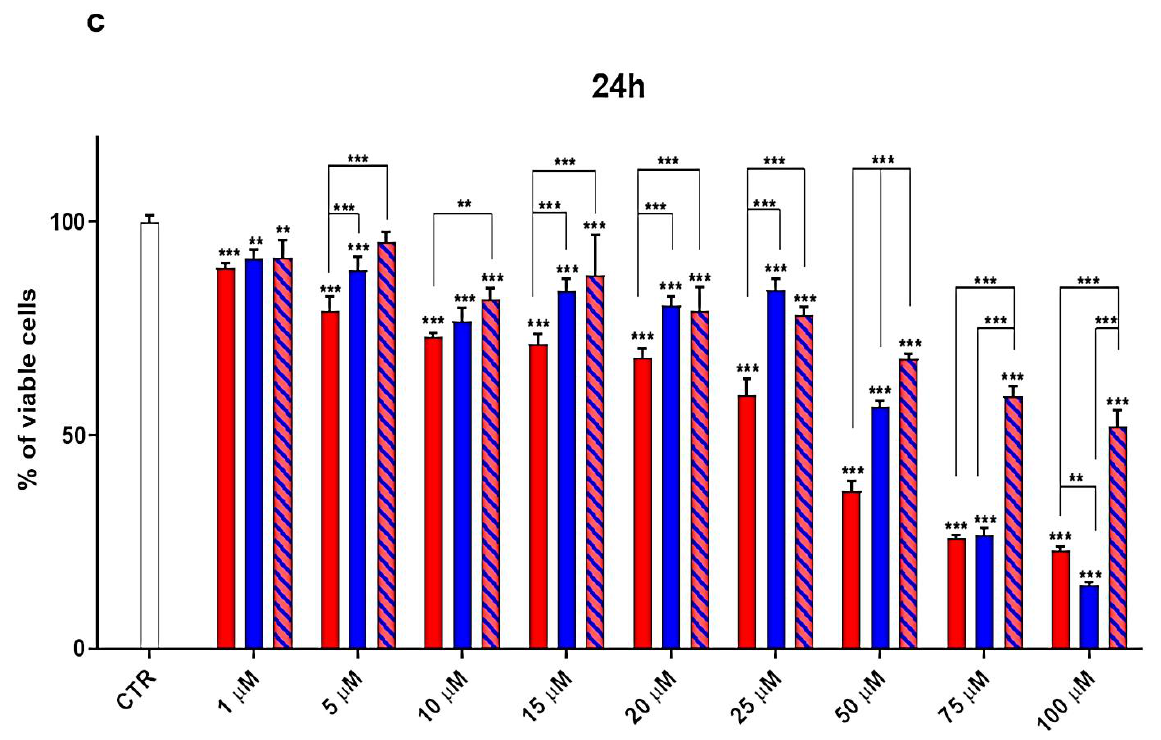
Figure 3. Dose- and time-dependent cytotoxicity activity of G4K, UA and UA-G4K at 4 h ( a ), 12 h ( b ) and 24 h ( c ) toward HaCaT cells. Where not specified, the significance refers to control ( p > 0.05 ns; p < 0.05 *; p < 0.01 **; p < 0.001 ***).